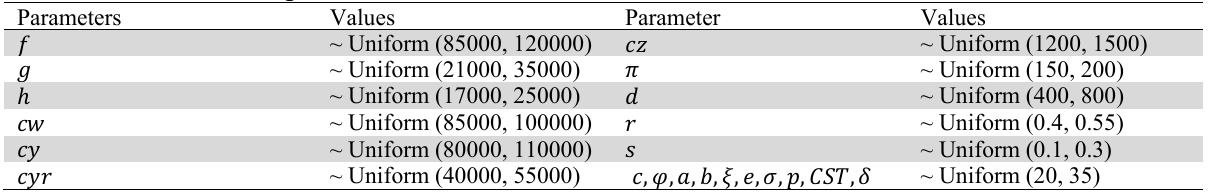
The sources of random generation of the nominal